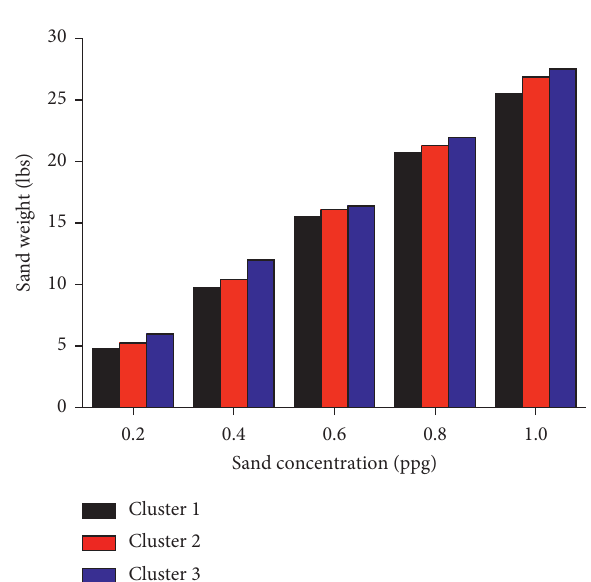
Figure 8: Sand distribution along perforation clusters at a pumping rate of 80 gallons/minute.